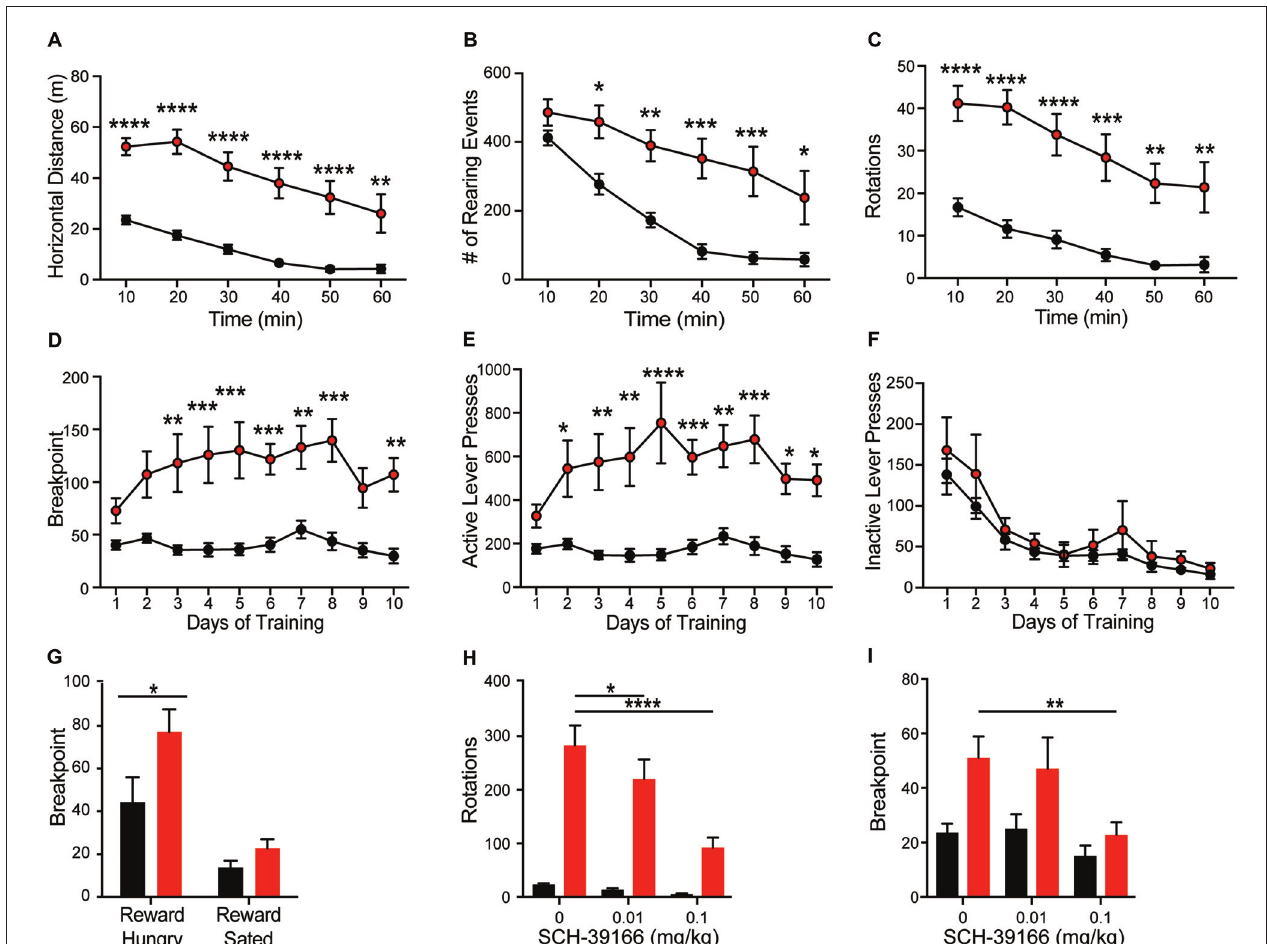
FIGURE 3 | Shank2 mutation results in increased locomotion, stereotypic and motivated behavior. Shank2 KOs exhibit increased locomotion (A) , vertical rearing (B) , and rotations (C) in the open field arena relative to WT animals. In the progressive ratio operant task, KOs have an increased breakpoint (number of lever presses at which the animal will cease to work for a fixed reward) (D) . The increased response is specific to the active lever (E) , not the inactive lever (F) , suggesting the increased breakpoint is motivationally driven. Devaluation of the reward through pre-feeding to satiety prior to testing decreases the breakpoint of both WT and KO rats (G) . Both the repetitive circling (H) and increased breakpoint (I) can be reduced by administration of the D1 receptor antagonist SCH-39166. In all panels WT animals are in black and KO animals are in red. Bars indicate SEM. ∗ p < 0.05, ∗∗ p < 0.01, ∗∗∗ p < 0.001, ∗∗∗∗ p <